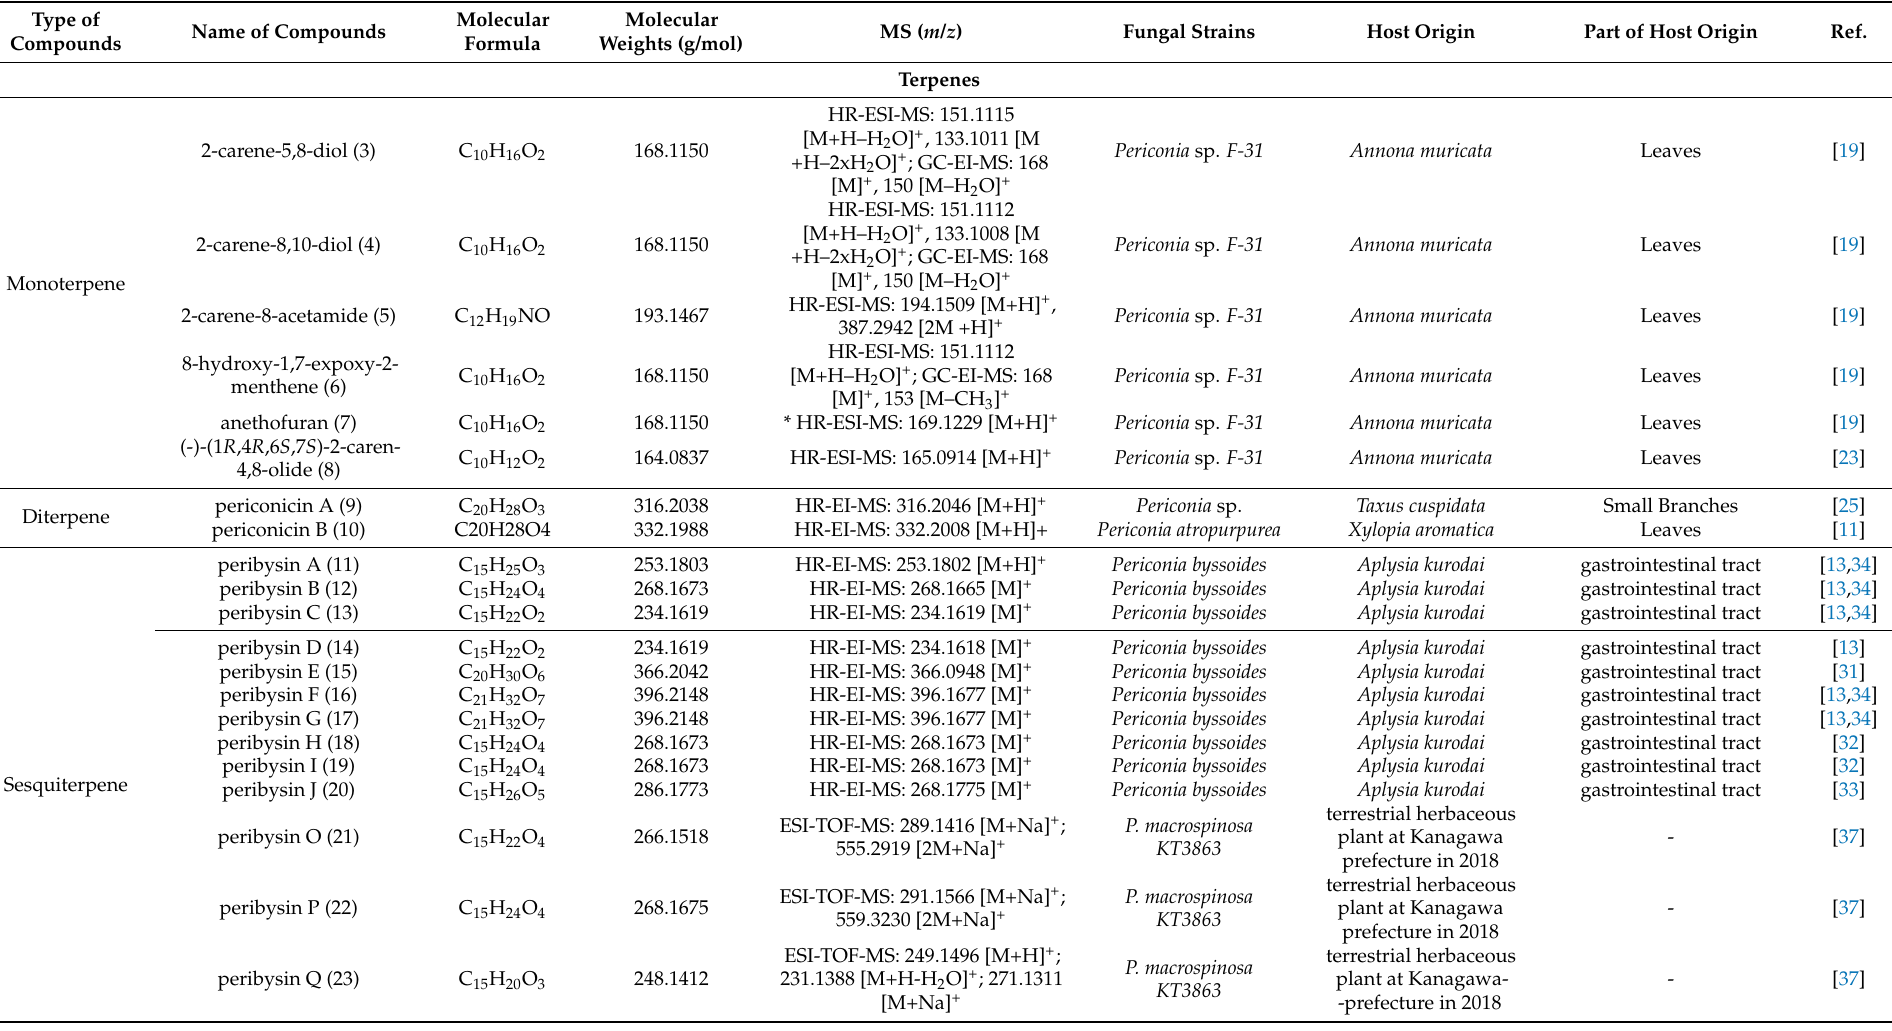
Table 1. Compounds from the Periconia fungal genus: type of compounds, MW and MS data, strain type, various host and